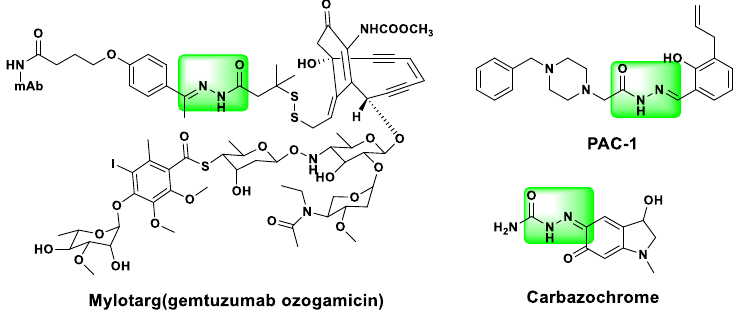
Figure 1. Structures of Mylotarg, PAC-1, and carbazochrome.